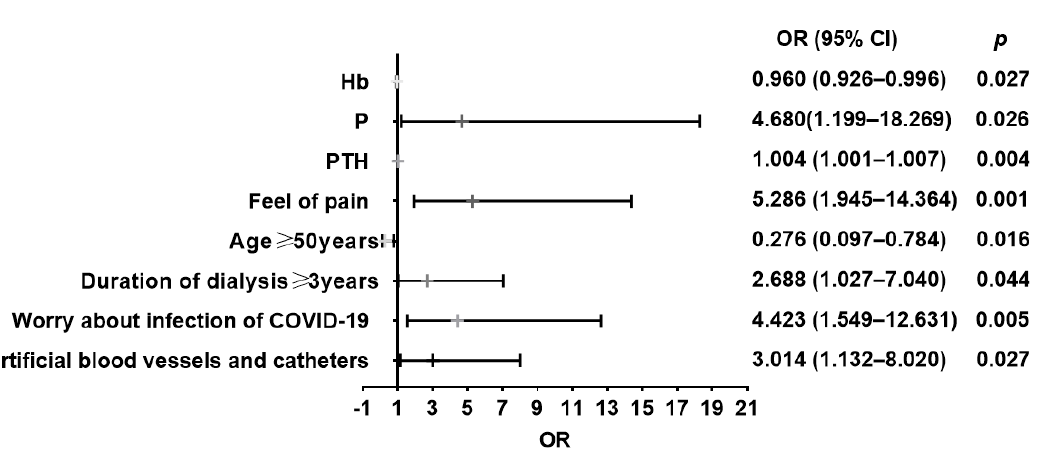
Figure 5. Logistic analysis of risk factors of anxiety in the MHD patients.